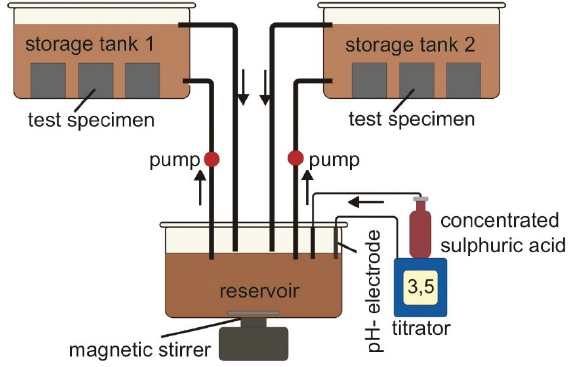
Figure 2. Schematic sketch of the acid test rig.